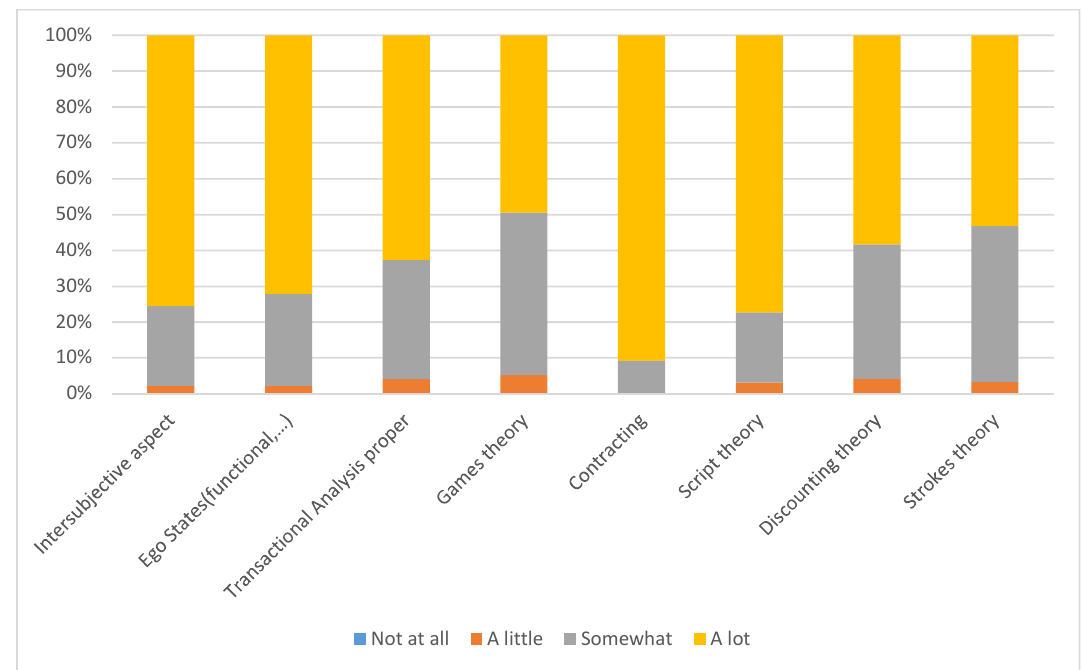
Figure 3 - How vaild the interviewee considers the main aspects of TA to be. n =